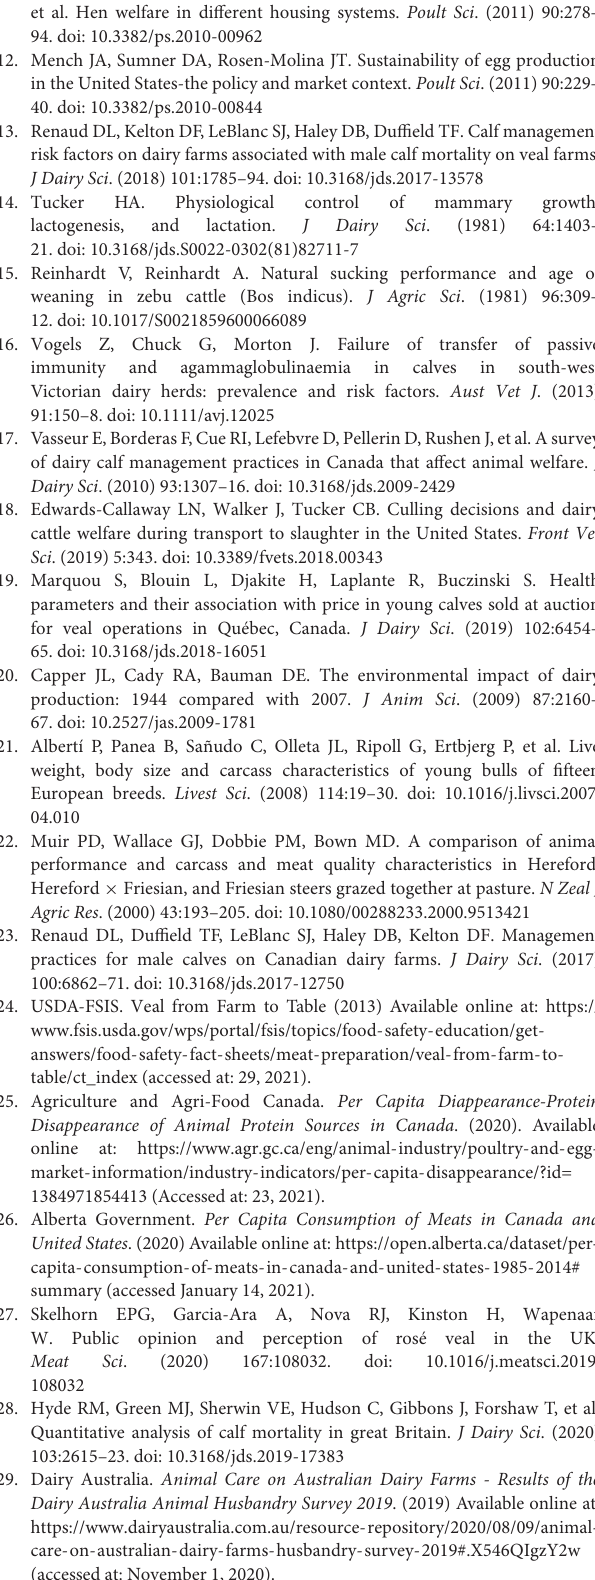
table/ct_index (accessed at: 29, 2021). 25. Agriculture and Agri-Food Canada. Per Capita Diappearance-Protein Disappearance of Animal Protein Sources in Canada . (2020). Available online at: